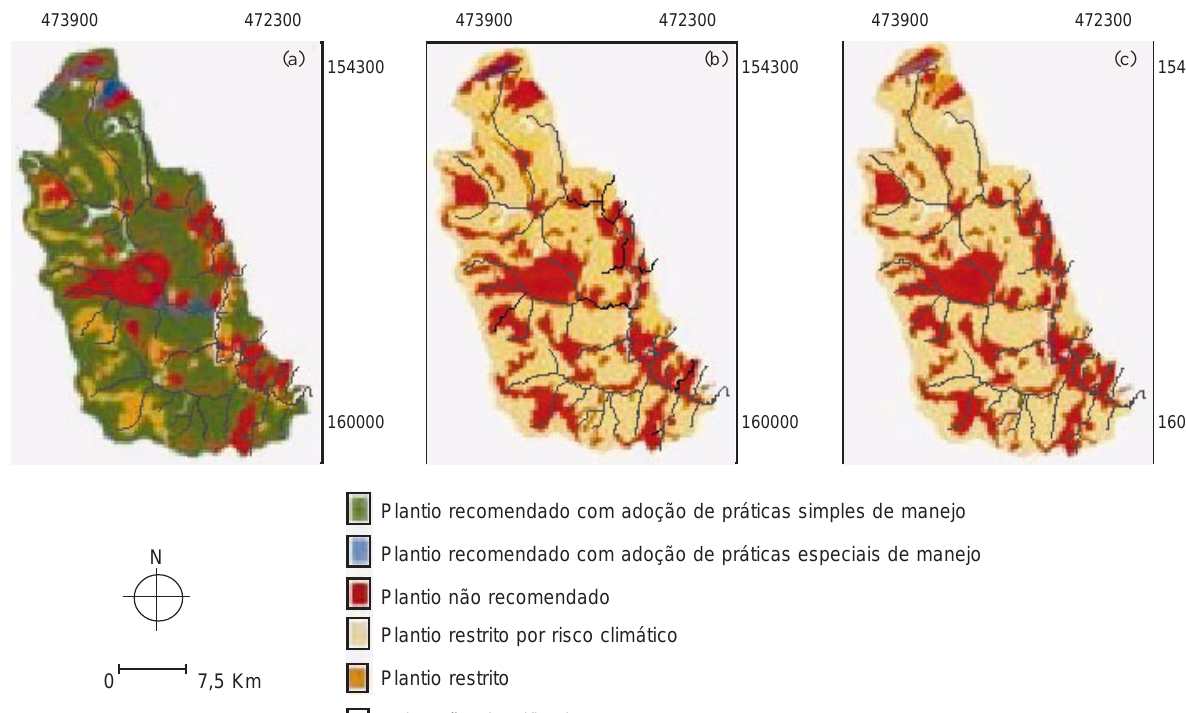
Figura 4. Mapa de aptidão agrícola das terras da Bacia do rio Jardim (DF) para a cultura do milho para as datas de plantio: (a) 11 a 20/10; (b) 11 a 20/11, e (c) 11 a